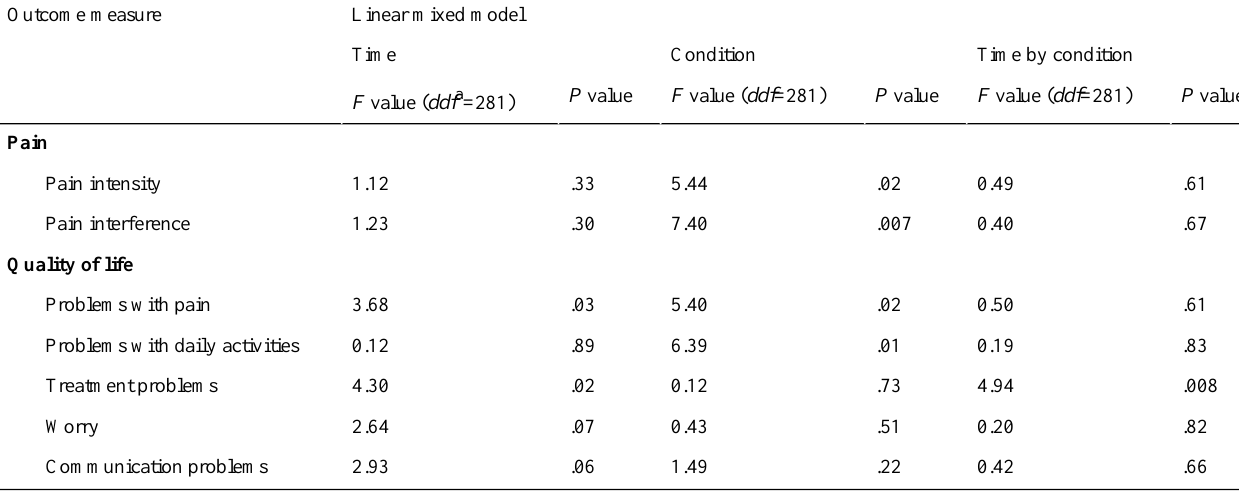
Table 3. Adolescent reported primary outcomes, linear mixed models.